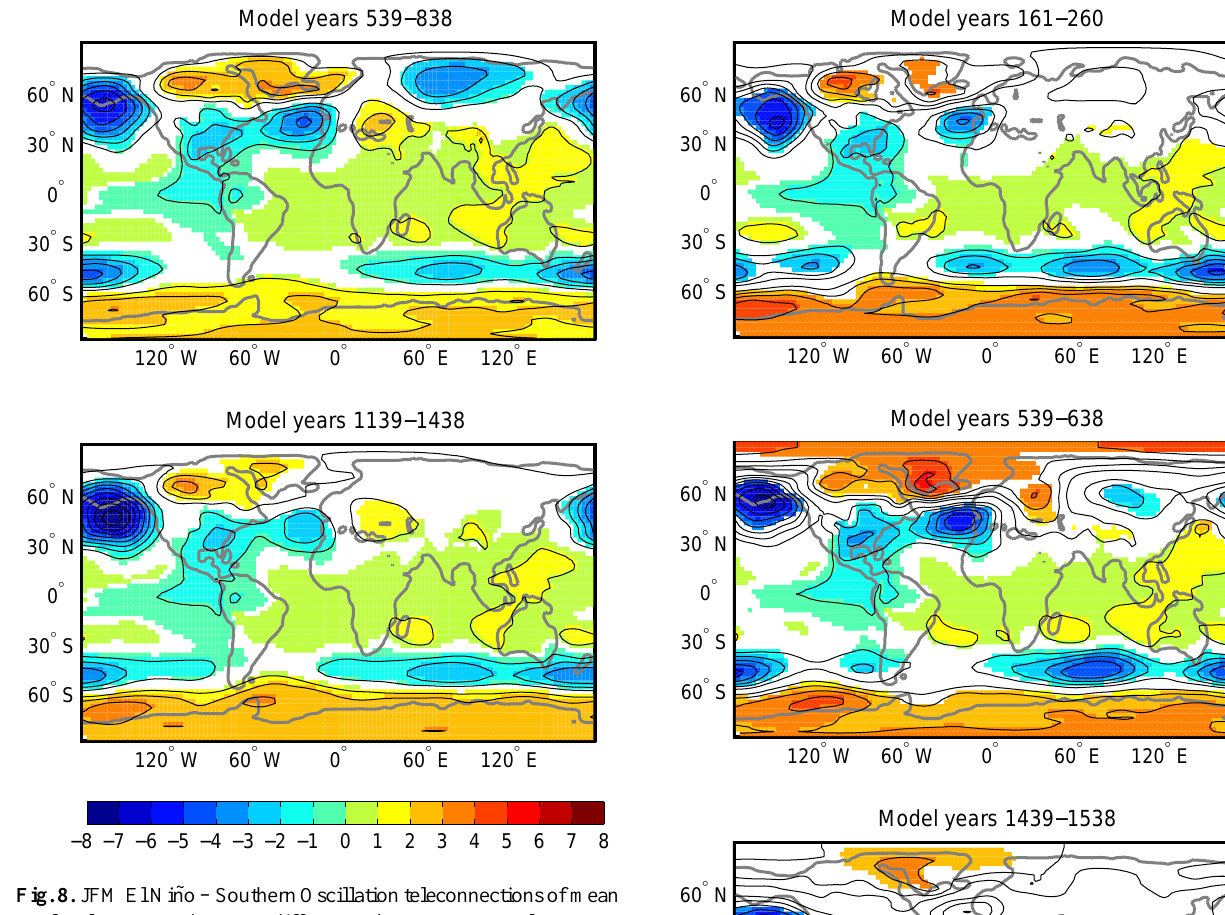
Fig. 8. JFM El Ni˜no – Southern Oscillation teleconnections of mean sea level pressure shown as differences between seasonal averages over El Ni˜no years and La Ni˜na years for 300-yr time-slices of the GS12 simulation. Model years 539–838 (upper panel), and 1139– 1438 (bottom panel) of the GS12 simulation. Units are hPa, contour interval 1hPa (excluding the 0hPa contour). In shading, statistically significant differences (at the 95% level) are displayed. The coast- line is defined at 20% of the land fraction.